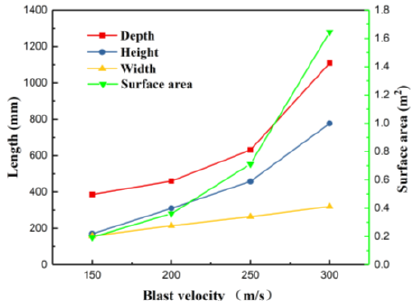
Figure 5. E ff ect of blast velocity on the raceway Figure 5. Effect of blast velocity on the raceway size. Figure 5. Effect of blast velocity on the raceway size.